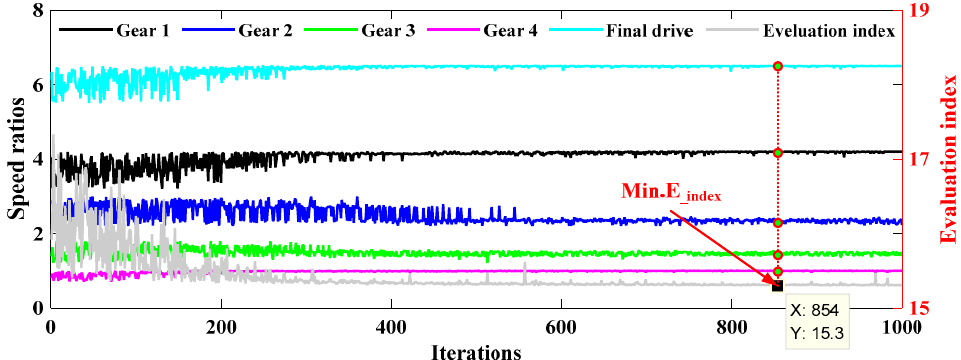
Figure 13. The optimal speed ratios.